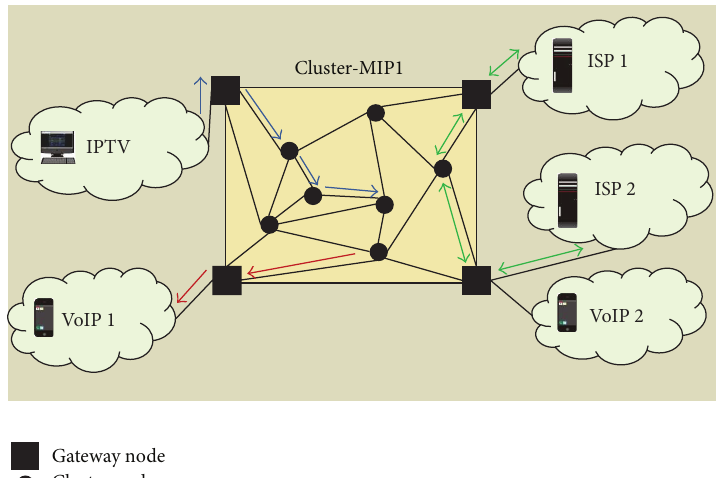
Figure 3: MIP multimedia cluster.